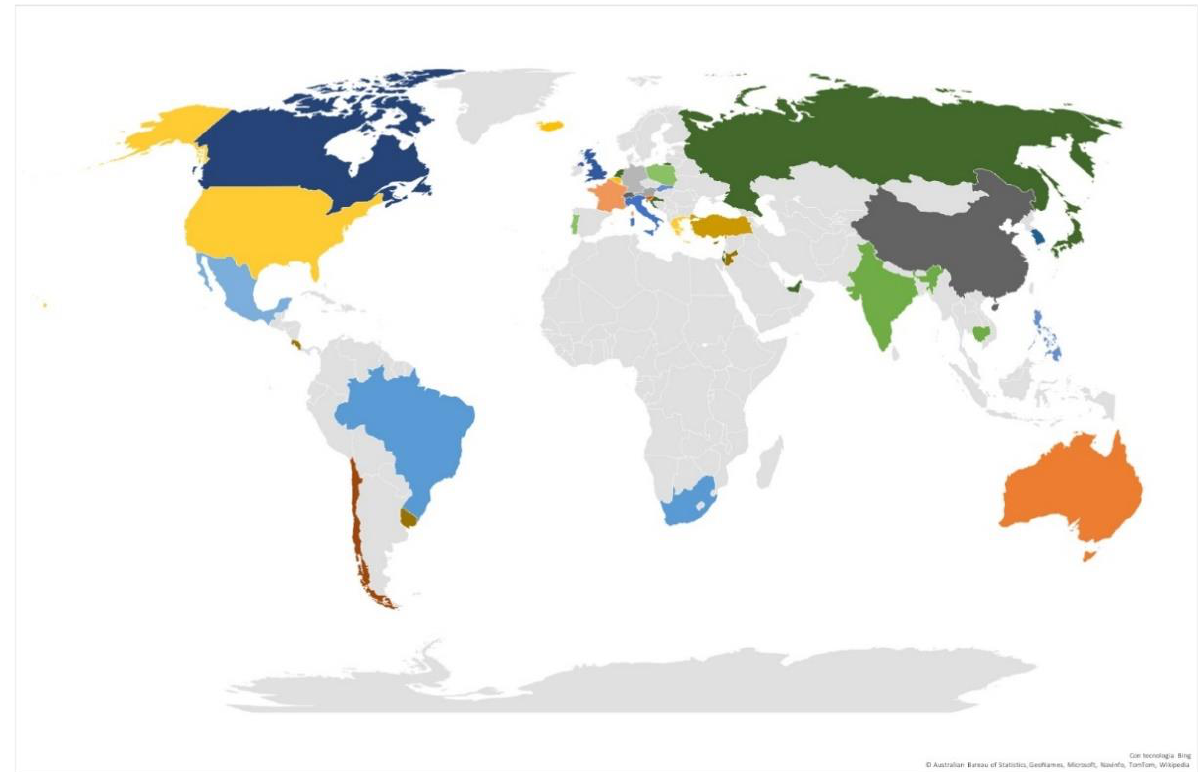
Figure 1. Geographical distribution of the sample. Legend: 0.4%: Russian Federation, United Arab Emirates, The Netherland, Croatia, San Marino, Japan, Israel, Australia; 0.5%: Uruguay, Jordan, Cyprus, Costa Rica; 0.6%: Philippines, Slovakia; 0.7%: Cambodia, India; 0.8%: United Kingdom; 1%: Brazil, South Africa; 1.2%: Greece, USA; 1.3%: Portugal, Poland; 1.4%: Turkey; 1.6%: Chile; 1.7%: Belgium, Iceland; 1.9%: Canada; 2%: France; 2.2%: Austria; 2.5%: Mexico; 2.8%: Germany; 2.9%: Spain; 4.1%: Switzerland, China; 5.4%: South Korea; 8%: Slovenia; and 50%: Italy. Before the advent of the COVID-19 pandemic, 38.7% of the sample had a full-time job ( n = 396), and with the advent of the COVID-19 pandemic, 76.5% of them